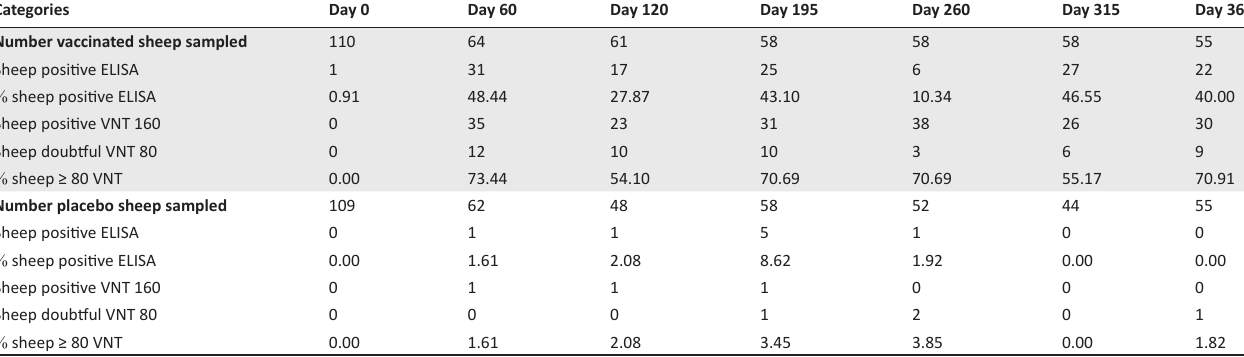
TABLE 5: Enzyme-linked immunosorbent assay and viral neutralisation test results in sheep.